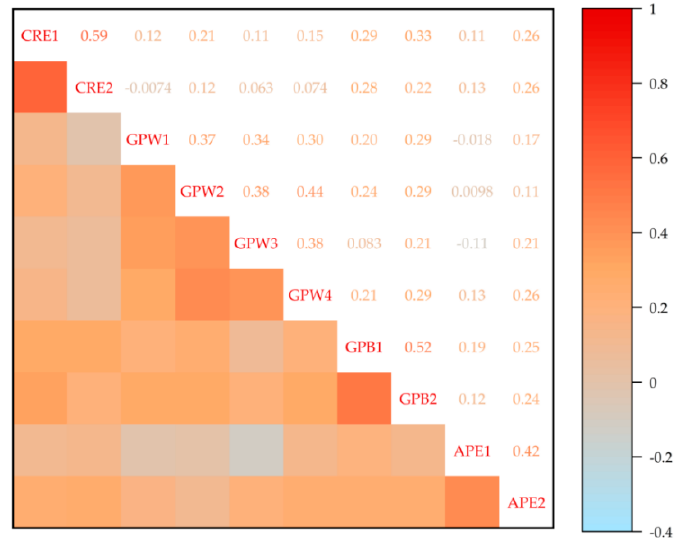
Figure 4. Heat map of the correlation coefficient matrix.